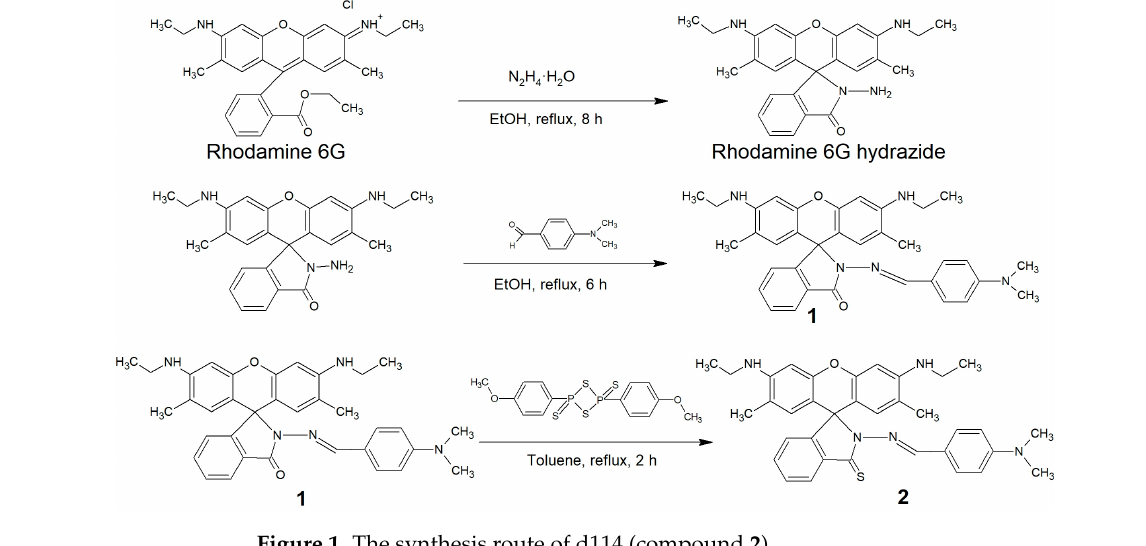
Figure 1. The synthesis route of d114 (compound 2).